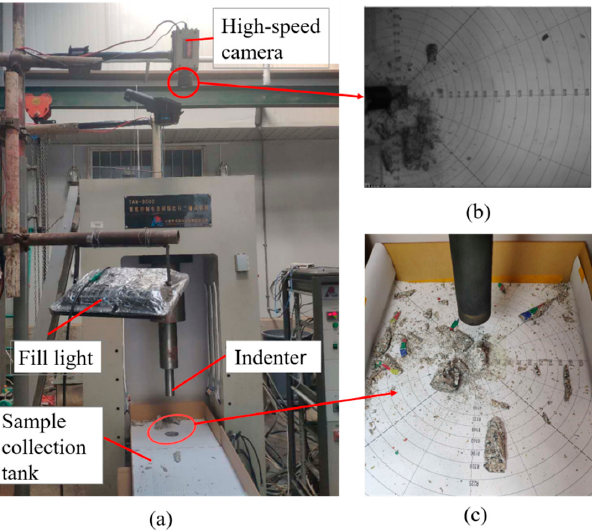
Figure 2. Uniaxial compression crushing dynamic capture system ( a ) Uniaxial compression load- ing system ( b ) High-speed camera images( c ) Spatial distribution of fragments. system ( b ) High-speed camera images( c ) Spatial distribution of